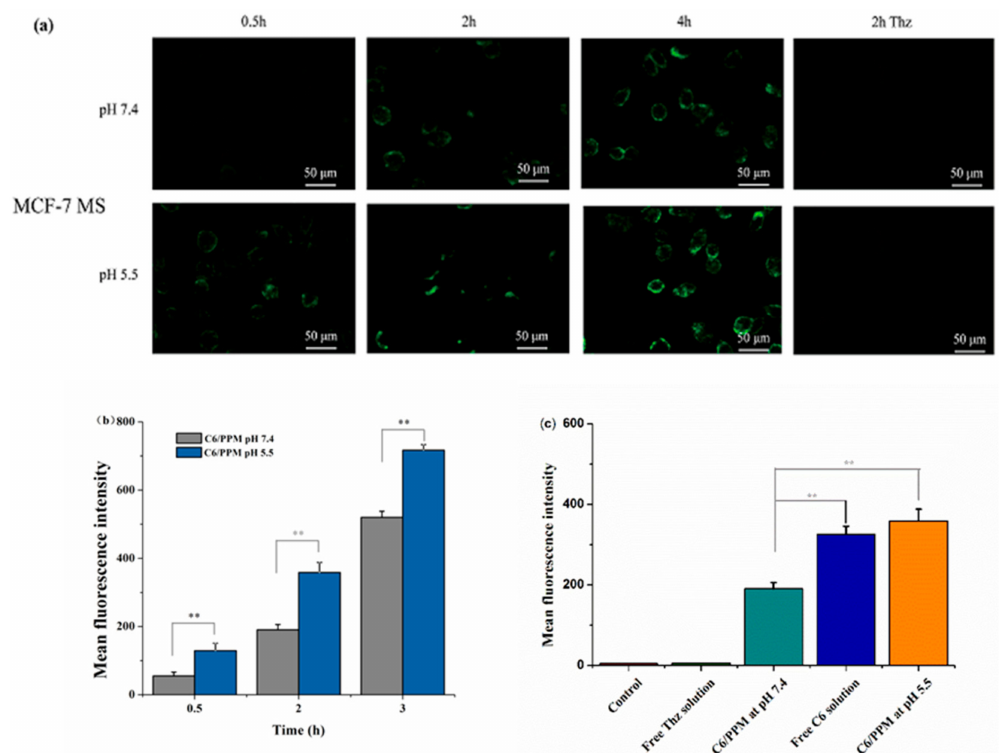
Figure 7. ( a ) Confocal images of MS incubated with C6 / PPM at pH 7.4 and 5.5 for 0.5, 2, and 4 h. ( b ) Fluorescence intensity of MS incubated with C6 / PPM at pH 7.4 and 5.5 for 0.5, 2, and 4 h as determined by flow cytometry ( n = 3). ( c ) Fluorescence intensity of MS incubated with C6 solution and C6 / PPM at pH 7.4 and 5.5 for 2 h as determined by flow cytometry ( n = 3). Scale bar, 0.05 mm. ** p <